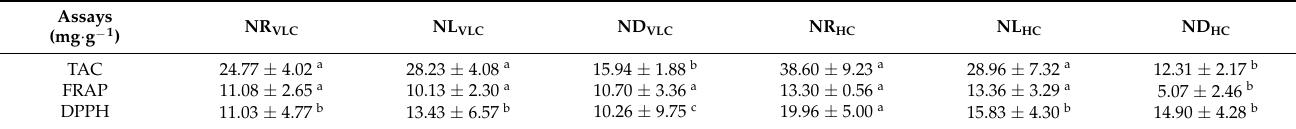
Table 5. Summary of antioxidant activities on the 10th day performed by TAC, FRAP, and DPPH assays (represented as mg · g − 1 ascorbic acid equivalent) subjected to NR VLC , NL VLC , ND VLC , NR HC , NL HC , and ND HC conditions in the native isolate Monoraphidium sp. CABeR41. Values indicated are mean average ( n = 3) ± S.E.; different lowercase letters indicate the statistical significance by two-way ANOVA with p -value < 0.05 using post hoc analysis by Tukey’s honestly significant difference (HSD).